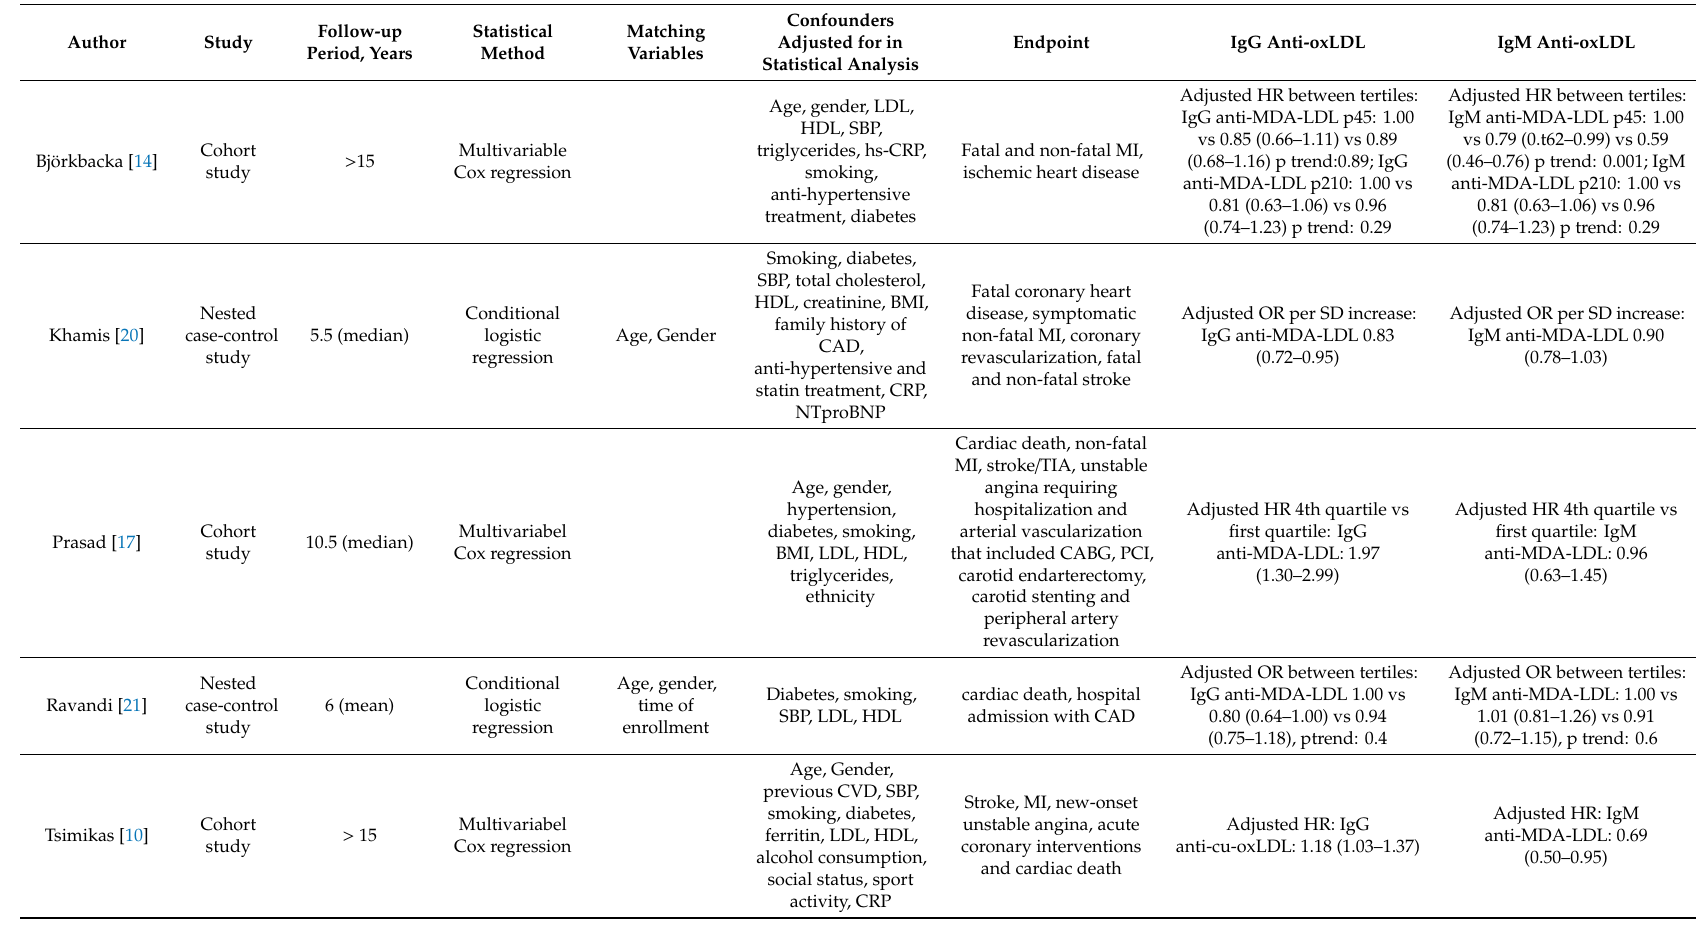
Table 3. Anti-oxLDL antibodies and cardiac endpoints in subjects without prevalent coronary artery